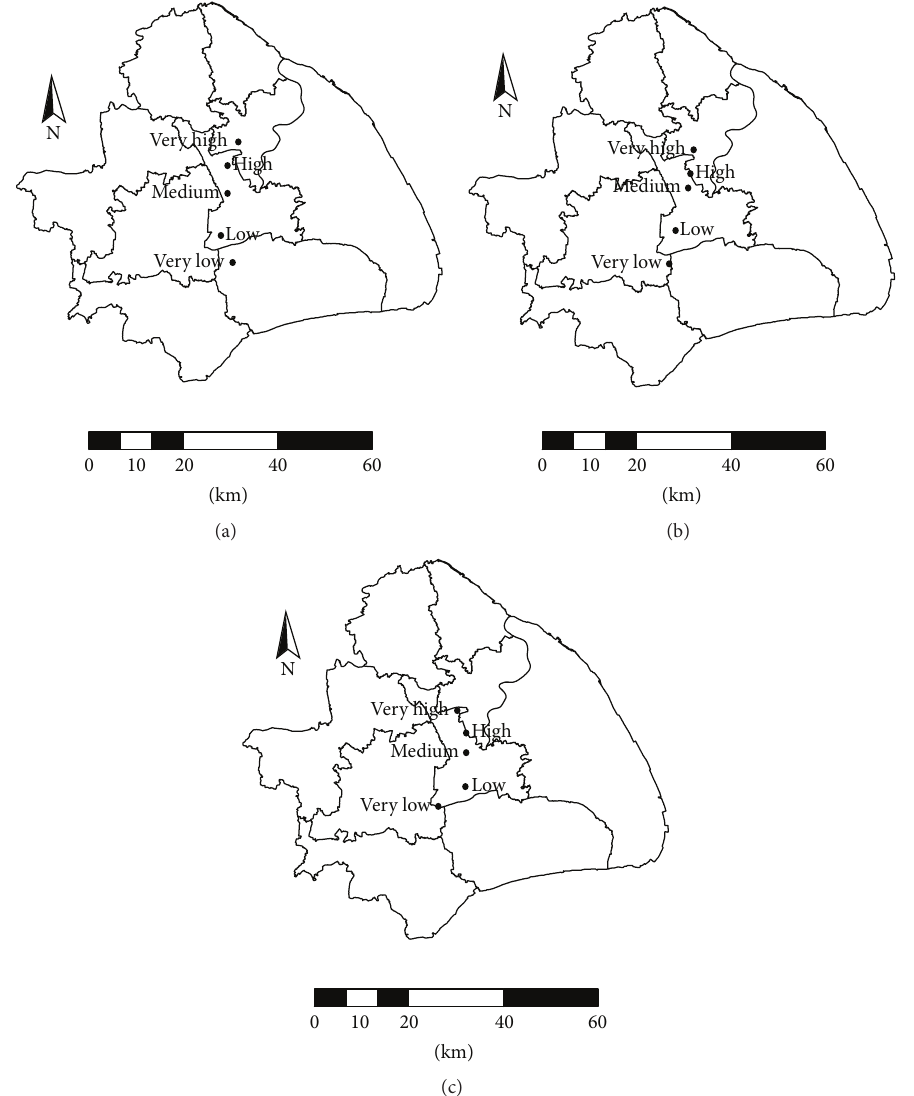
Figure 6: The centroid of different LST classes from 1989 to